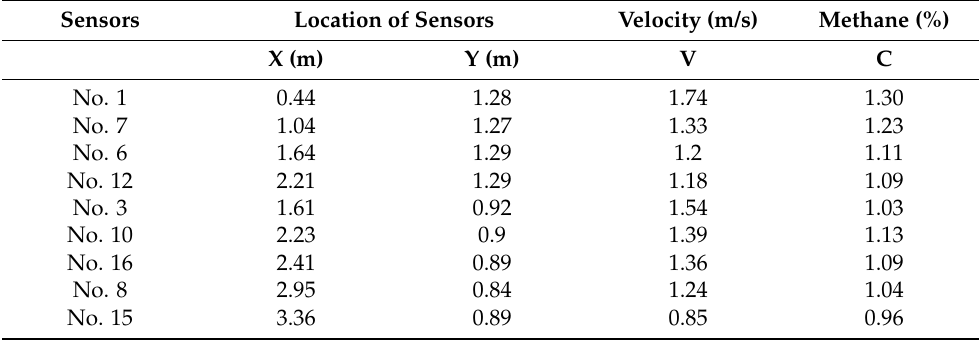
Table 1. Average air velocities and methane concentrations.